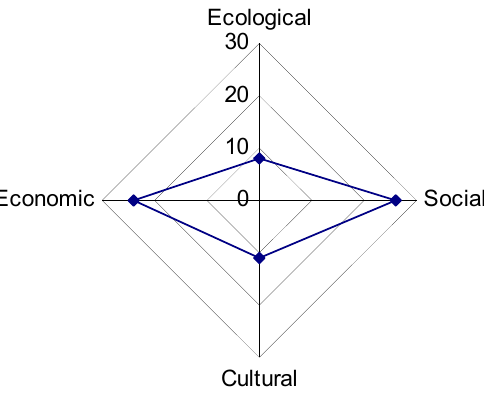
Figure 6. Role of landscapes’ stakeholders regarding different dimensions of local and regional development in the lower part of the Kovda River catchment.